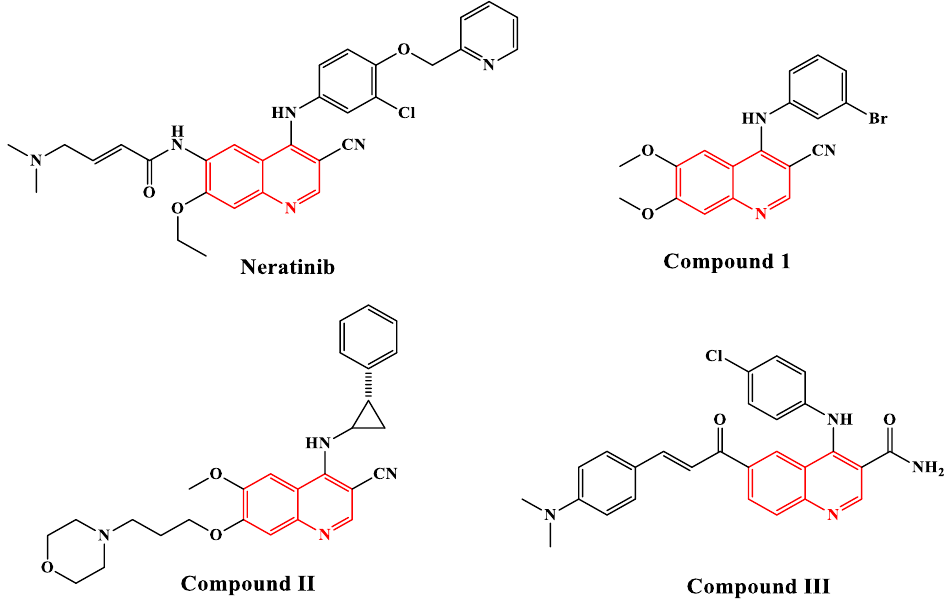
Figure 1. Structure of some quinoline-based EGFR inhibitors.